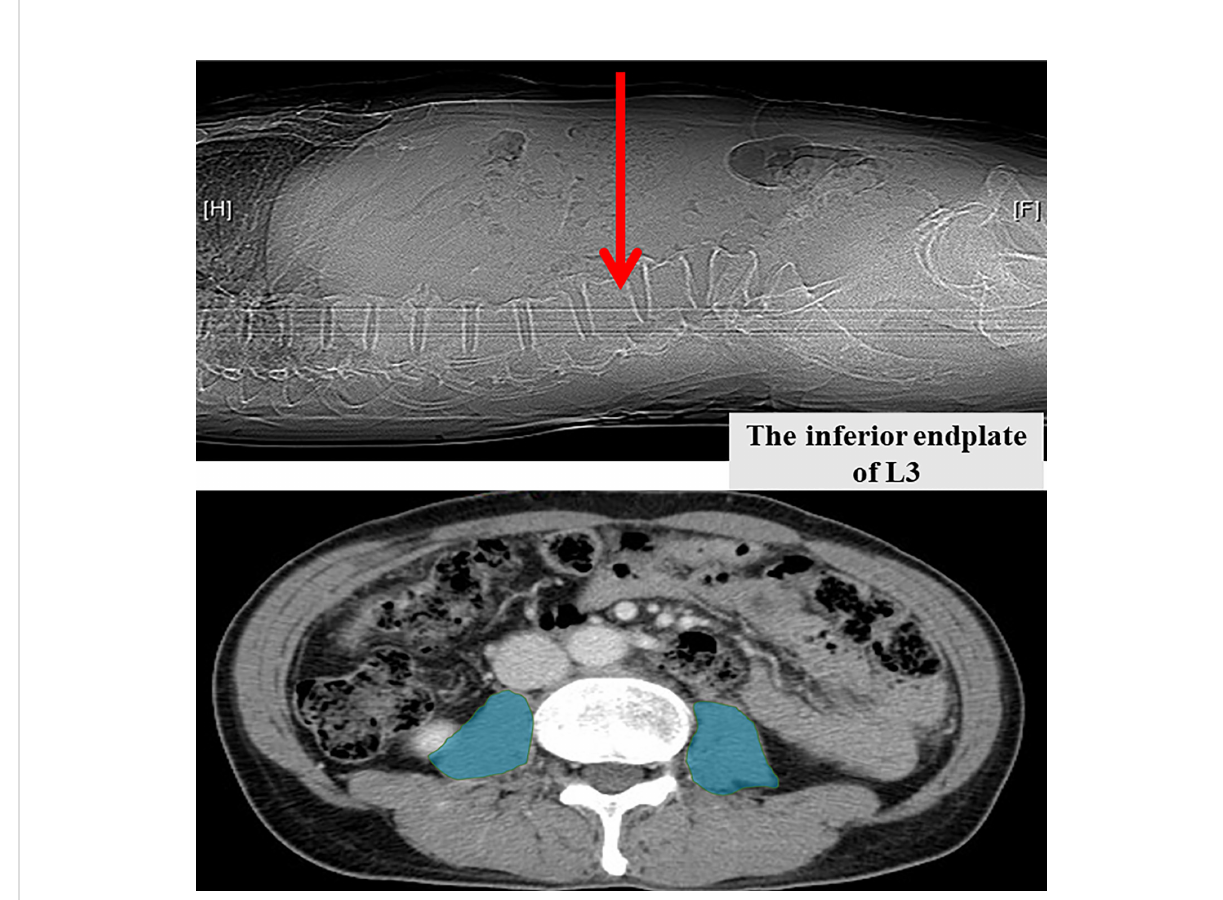
FIGURE 1 Measurement of bilateral psoas muscle area at the inferior endplate of the third lumbar